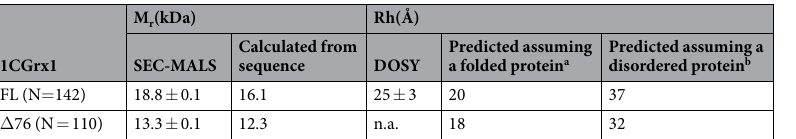
Predicted assuming a disordered protein b